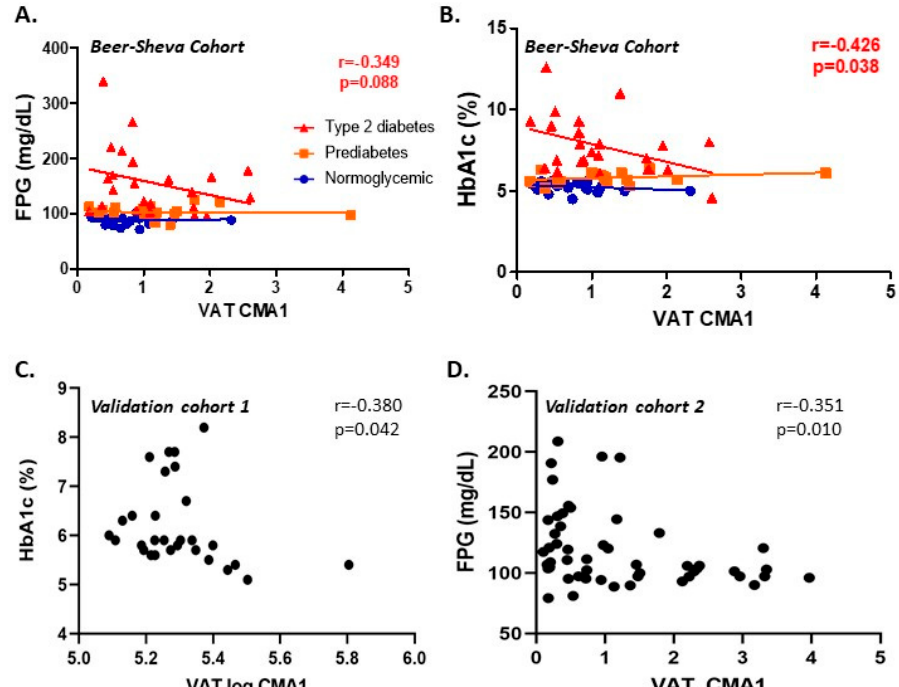
Figure 3. Associations between VAT CMA1 gene expression and glycemic parameters in the Beer–Sheva and Leipzig independent cohorts. Spearman’s associations between VAT CMA1 gene expression and FPG ( A ) or HbA1c ( B ) among the Beer–Sheva cohort ( n = 65, all with body mass index ≥ 30 kg/m 2 ), stratified into those with normal glucose homeostasis (normoglycemic, blue circle), prediabetes (orange square), or type 2 diabetes (red triangle). r denotes Spearman’s rank correlation coefficient (Rho, ρ ) among participants with type 2 diabetes. ( C ) Spearman’s rank correlation between log-transformed CMA1 expression in VAT assessed by microarray and HbA1c in the Leipzig validation cohort 1 ( n = 32, all with BMI ≥ 30 kg/m 2 ). ( D ) Spearman’s rank correlation between CMA1 expression in VAT and FPG in Leipzig validation cohort 2 ( n = 56, all with BMI ≥ 30 kg/m 2 ).